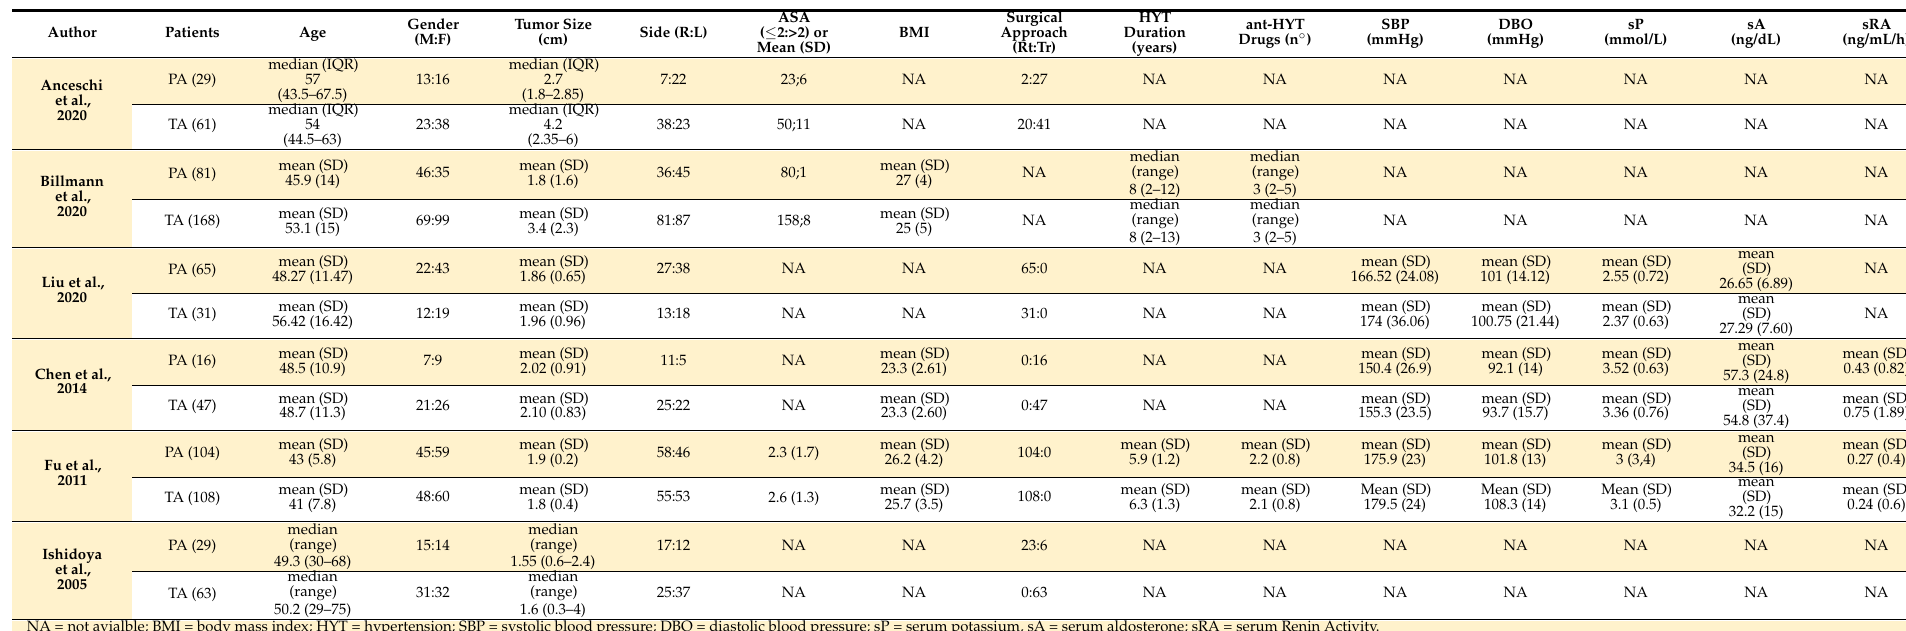
Table 2. Summary of published research: Baseline characteristics among eligible studies testing perioperative and functional outcomes of PA vs.